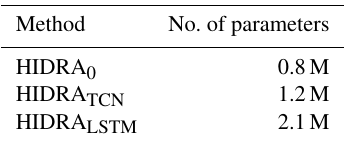
Table 6. Total number (in millions) of trainable parameters of HIDRA variants with different temporal